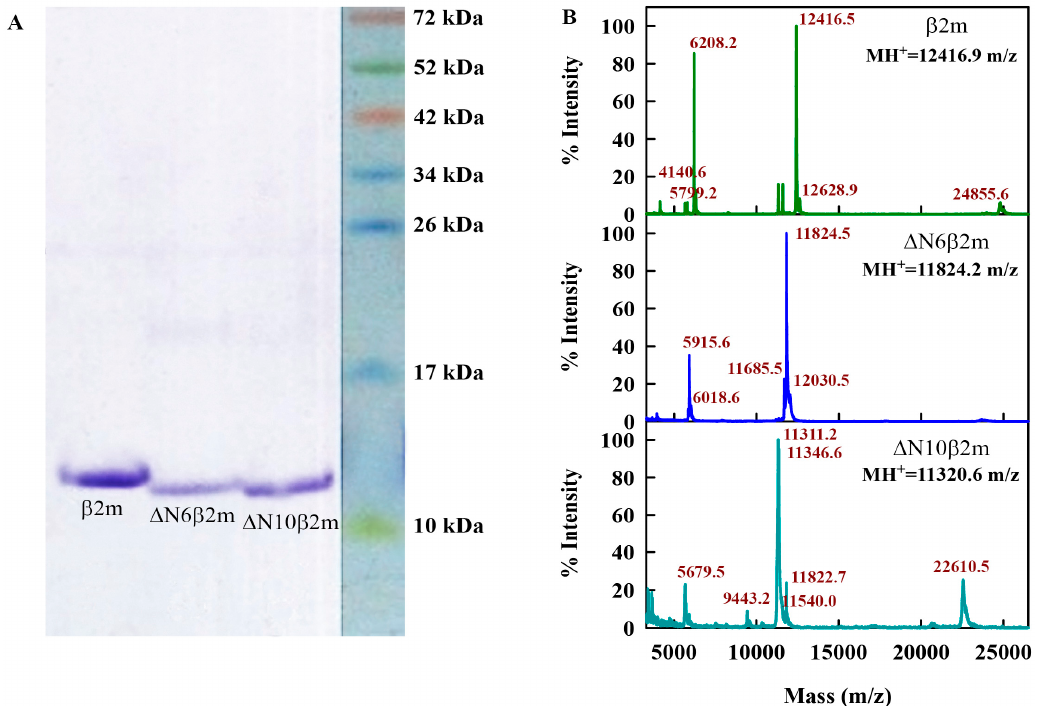
Figure 6. Characterization of the expressed and purified proteins. ( A ) Sodium dodecyl sulfate polyacrylamide gel electrophoresis (SDS-PAGE) of full-size β 2m and their truncated variants: ∆ N6 β 2m and ∆ N10 β 2m. ( B ) Ion mass spectra of the β 2m, ∆ N6 β 2m, and ∆ N10 β 2m. Peaks corresponding to main ion, double ion and dimer of main ion are seen for β 2m and ∆ N6 β 2m. For ∆ N10 β 2m the main peak has complicated form, which can be the result of superposition of the one ion peak and double charged ion peaks of dimers or trimers of protein.